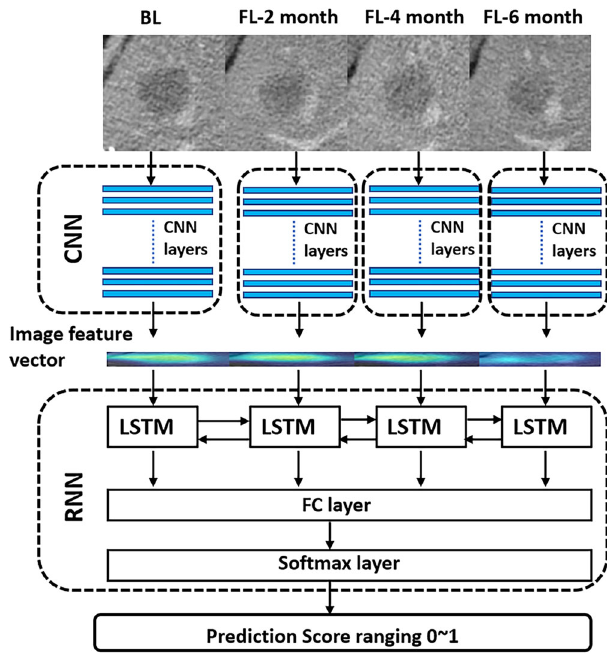
tuning set to classify DL-responder/ non-responder was 0.76